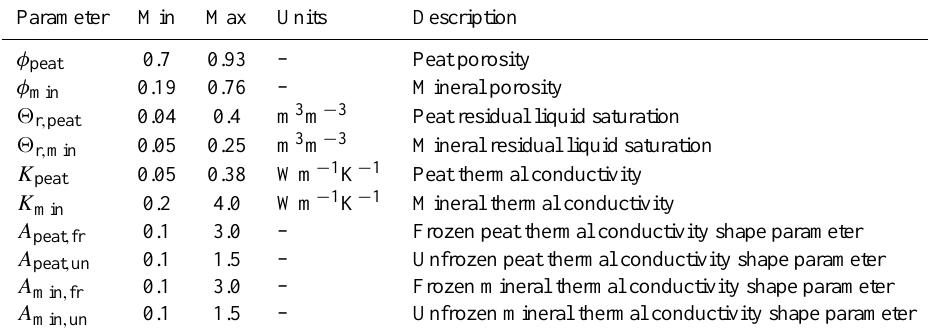
Table 1. NSMC parameter minimum and maximum bounds, units, and descriptions Parameter